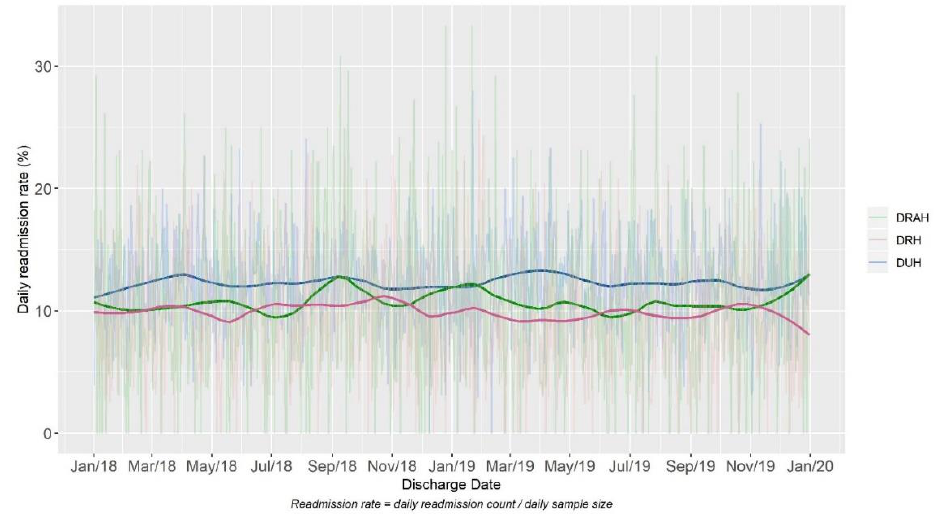
Figure 2. Readmission rate per day from 1 January 2018–31 December 2019 at three DUHS hospitals. Plots show a LOWESS smoothed curve in bold of the trend over time with the unsmoothed daily readmission rates behind.